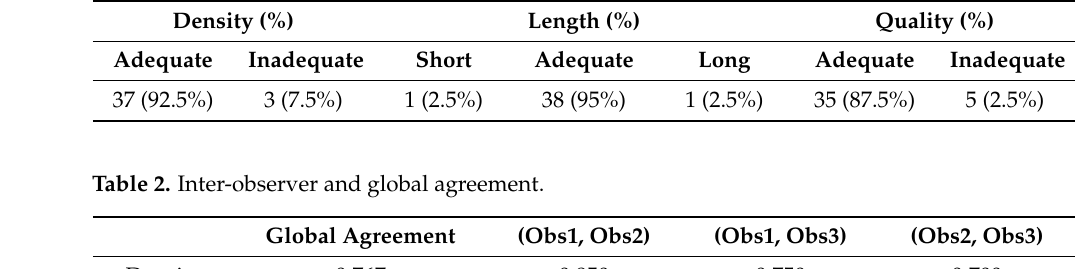
Table 2. Inter-observer and global agreement.